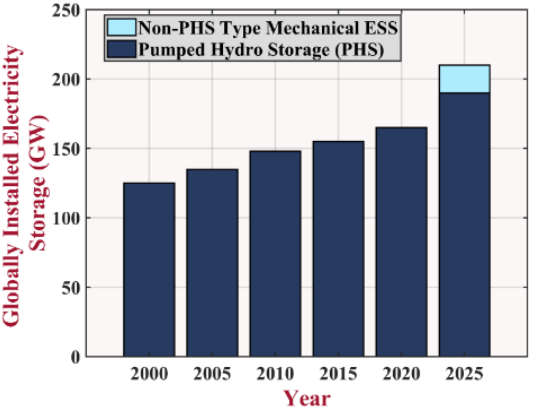
Figure 4. Global increase of pumped hydro storage over the years: it is expected to rise by almost 55 GW in a span of 25 years [3].